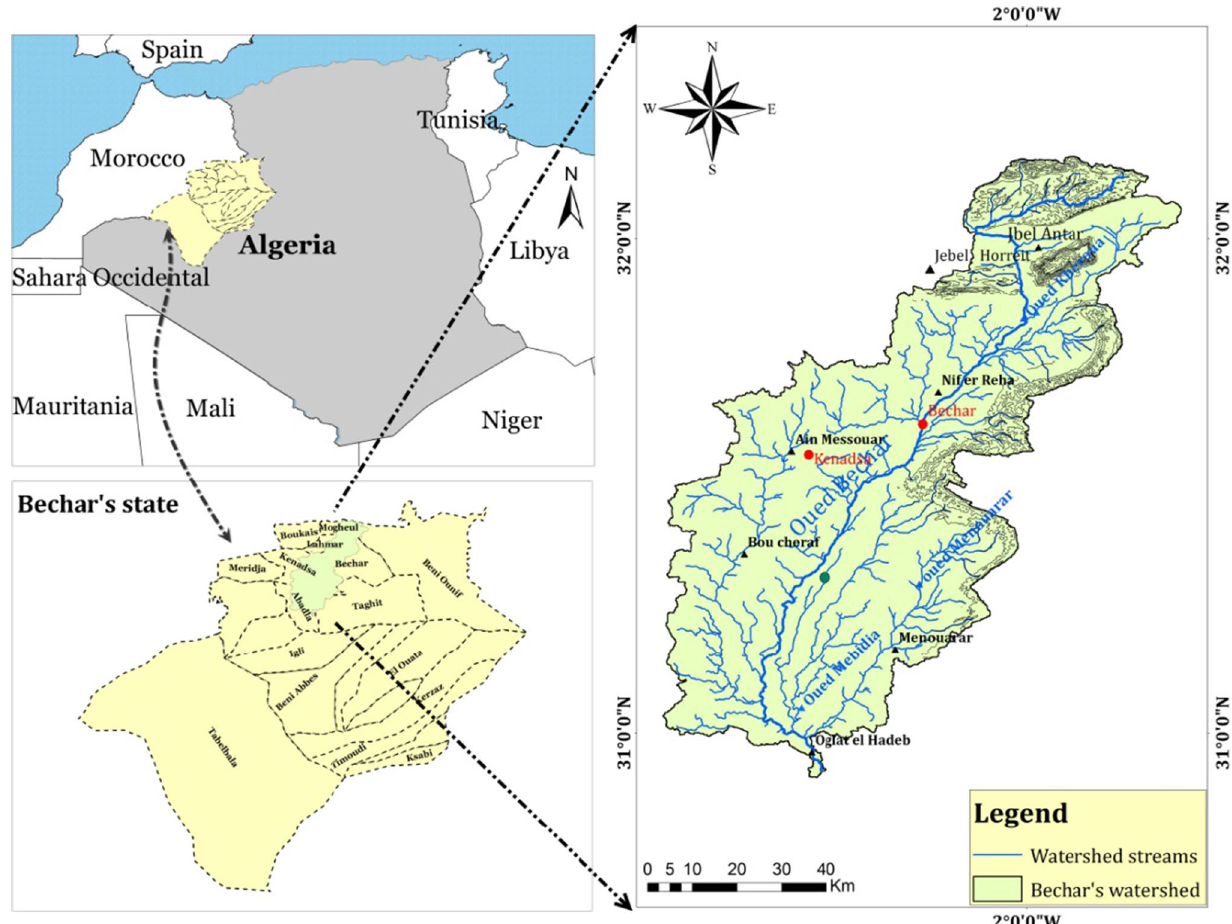
Fig. 1 The location of the